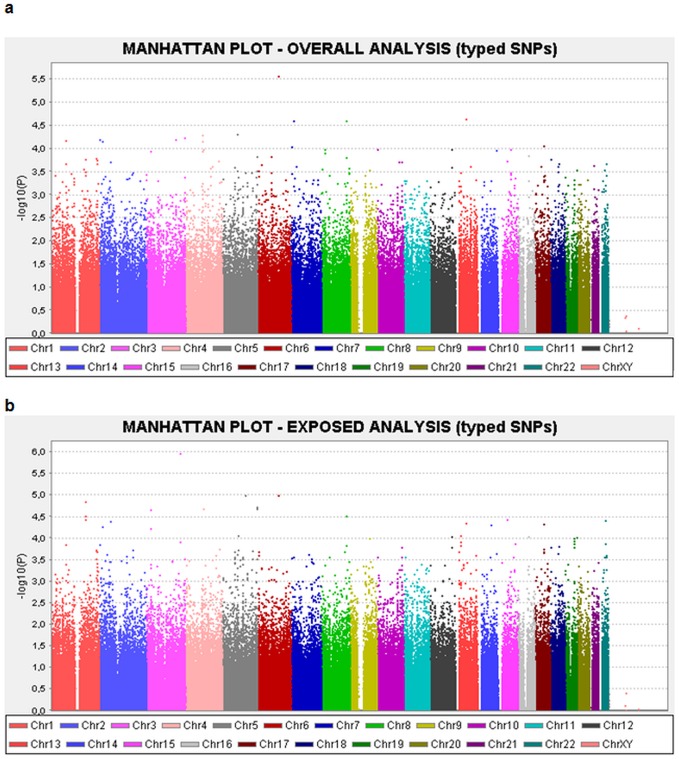
Manhattan plot of genotyped SNPs from logistic additive model.A) all samples, B) exposed samples.